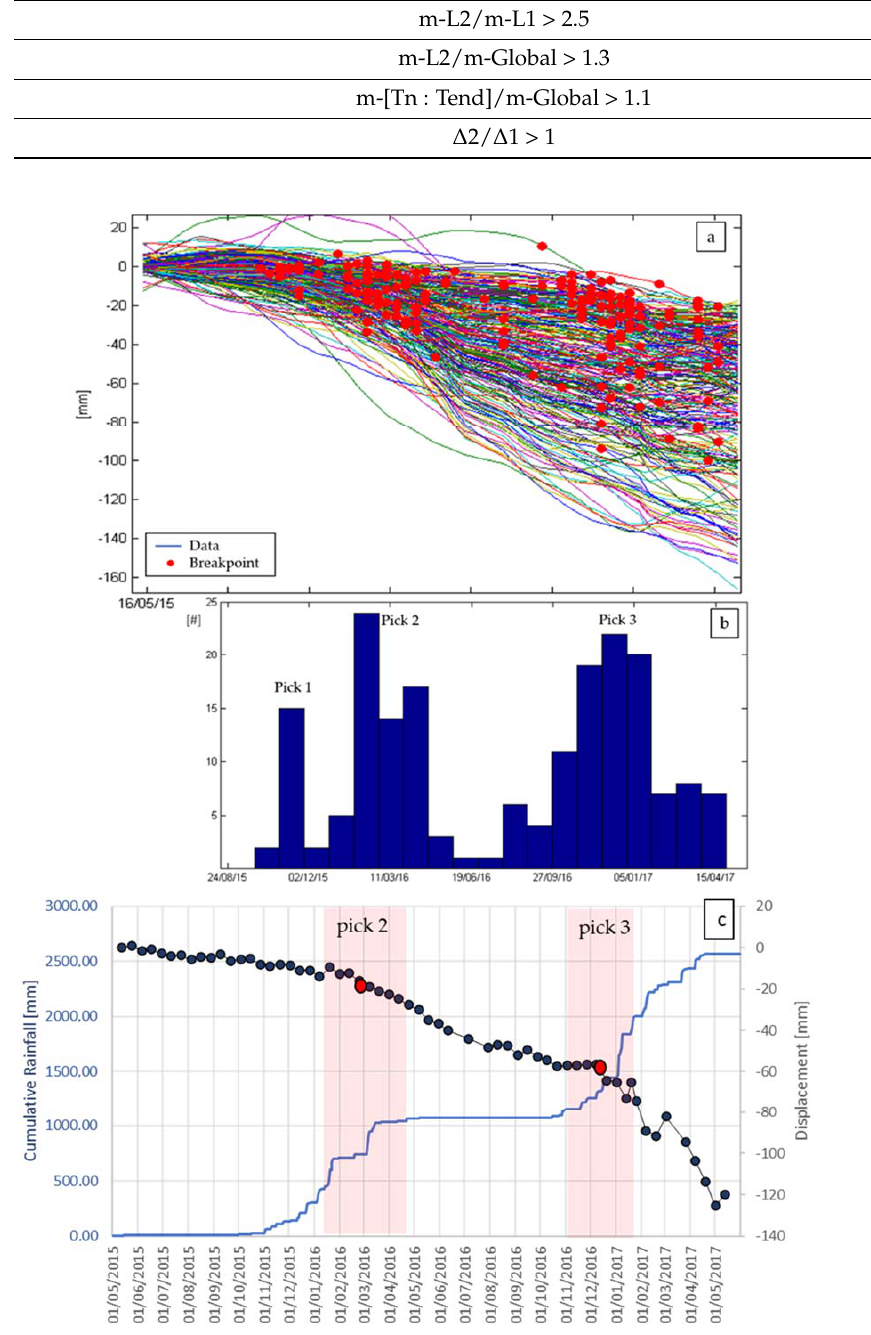
Figure 11. MSW segmentation analysis. ( a ) Diagram of all the analyzed time series and the detected breakpoints. ( b ) Histogram of the temporal distribution of the breakpoints. ( c ) Correlation between the displacements (black dots), rainfall records (blue line) and TCDA